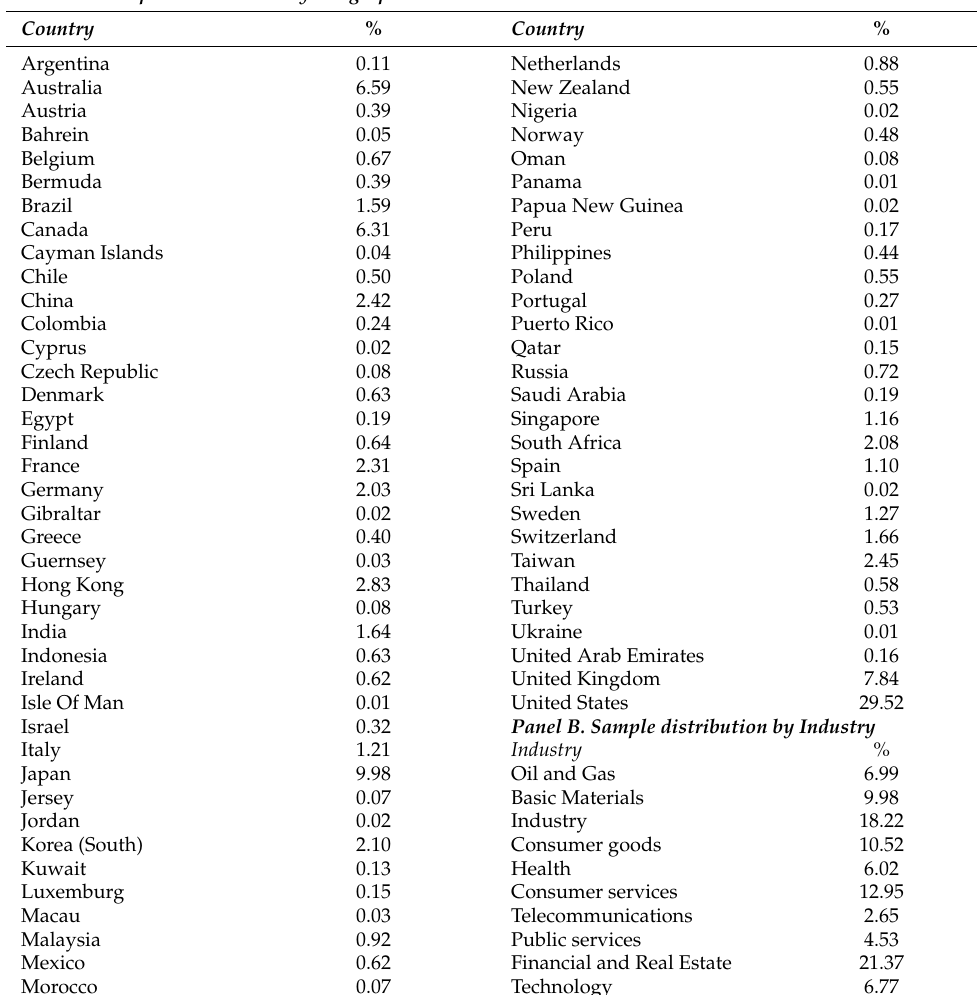
Table 1. Sample. Panel A. Sample Distribution by Geographic Zone Country